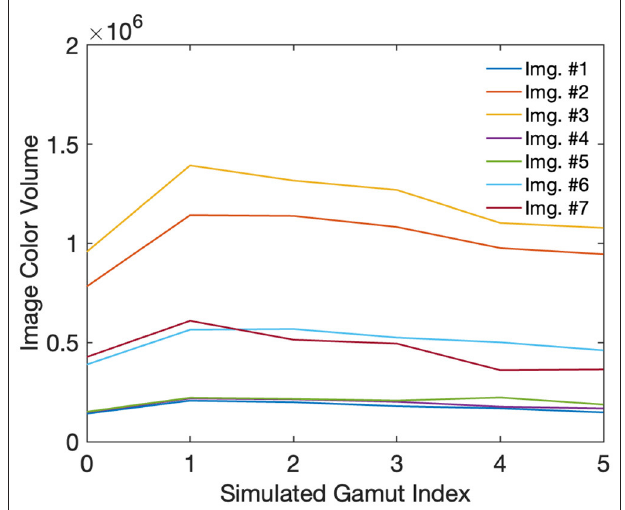
FIGURE 4 | Image CGVs across different gamut conditions. Each line corresponds to one image content. Gamut #0 was the checking condition, which was 30% luminance off from Gamut #1. The same image content with a higher CGV was expected to have higher brightness and colorfulness.